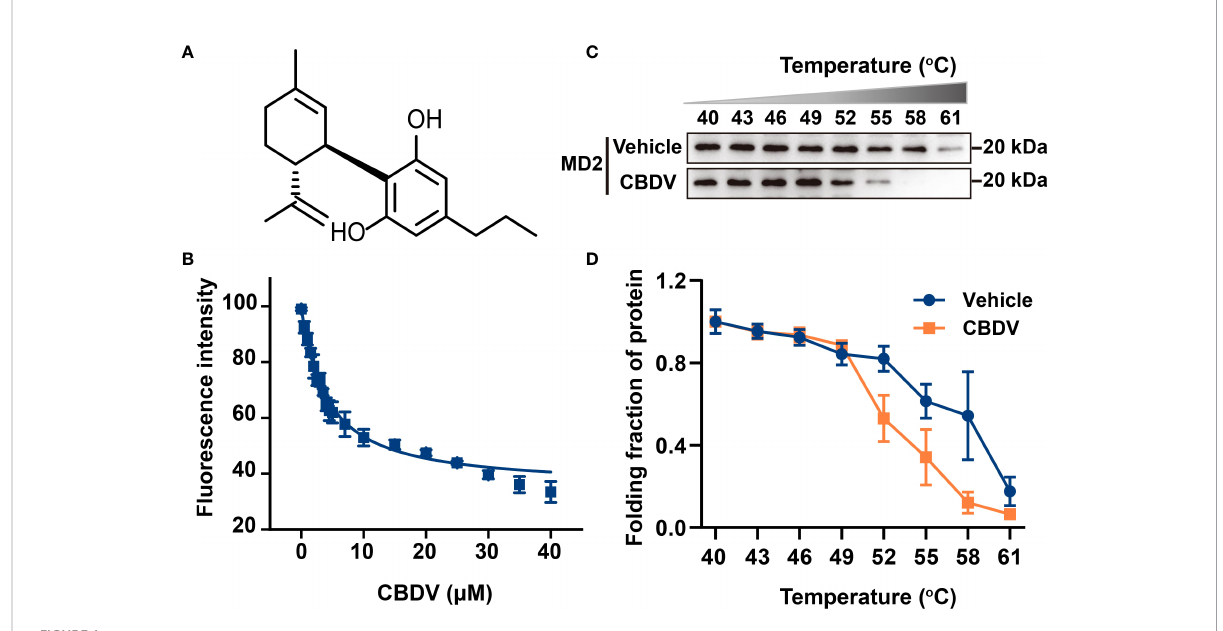
FIGURE 1 Biophysical binding of CBDV with MD2. (A) The chemical structure of CBDV. (B) Titration curve of MD2 intrinsic fl uorescence with the increasing concentrations of CBDV. Emission at 337 nm (excitation at 280 nm) was plotted against the titrated CBDV concentration. K d value of 3.9 ± 0.3 m M was derived by nonlinear least-squares fi tting of a one-site binding model for CBDV interacting with MD2. (C, D) Cellular thermal shift assay (CETSA) of MD2 with CBDV. CBDV binding decreased MD2 thermal stability ( D T m = -4.3 ± 0.1 °C). All experiments were performed three times independently, and data were given as the mean ±